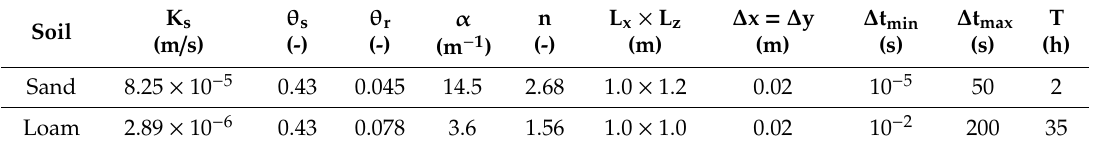
Table 1. Hydraulic parameters of the soil and numerical parameters used in Test